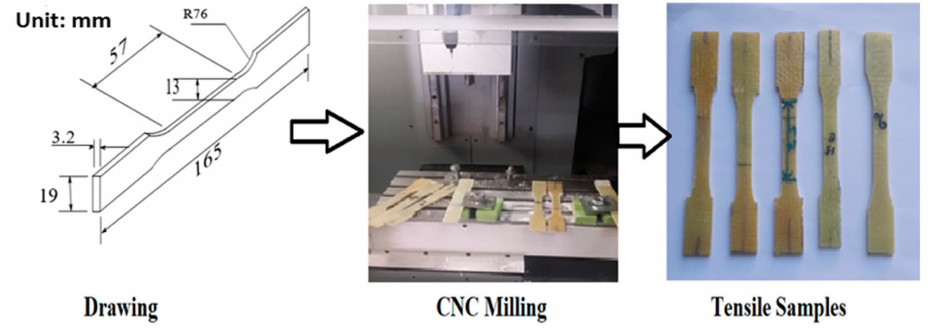
Figure 4. Testing